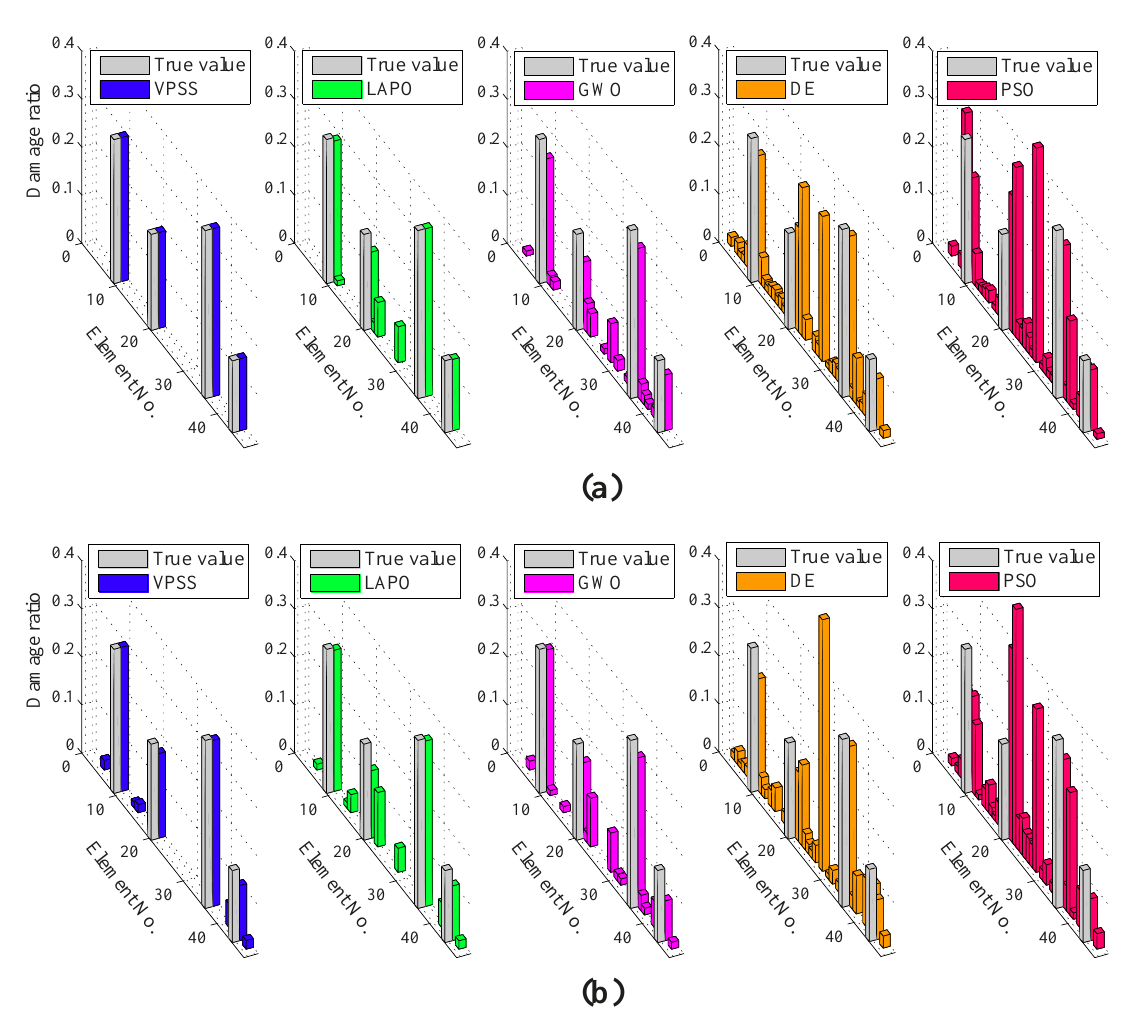
Figure 6. Damage identification results for the 47-bar planar truss under the ( a ) noise-free condition and ( b ) noisy condition. Table 3. Statistical results of the damage identification for the 47-bar planar truss.